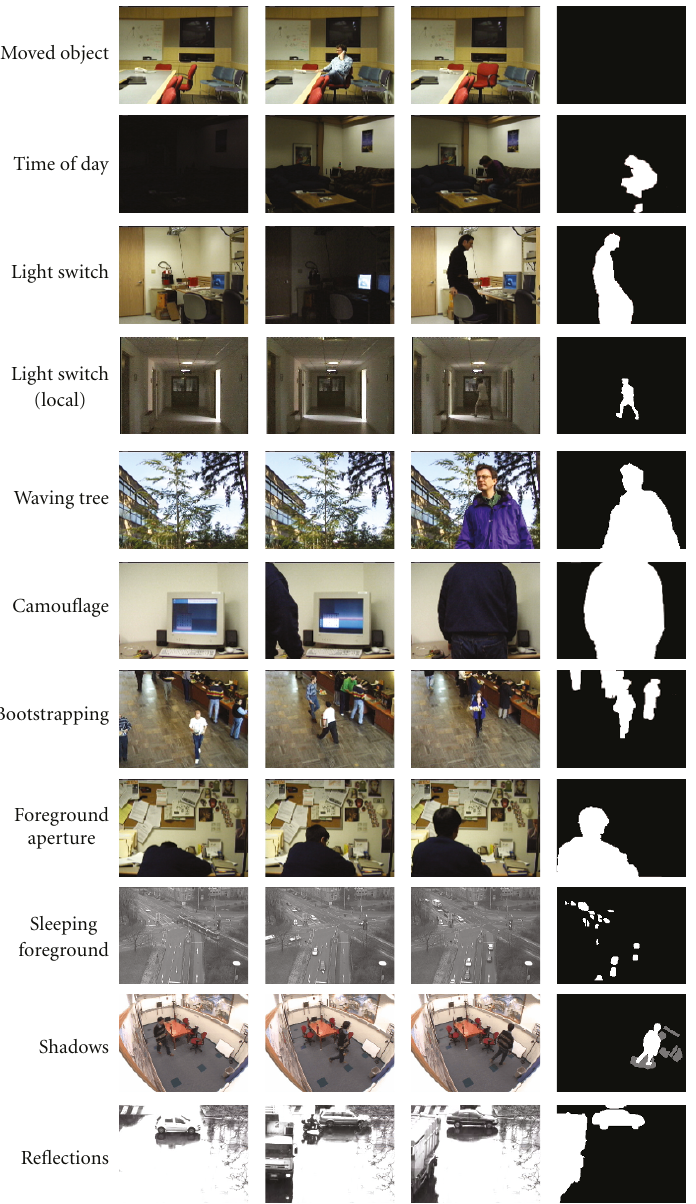
Figure 4: Key problems for the BG subtraction algorithms. Each situation corresponds to a row in the figure, the images in the first two column (starting from left) represent two frames of the sequence, the images in the third column represent the test image, and the images in the fourth column represent the ground